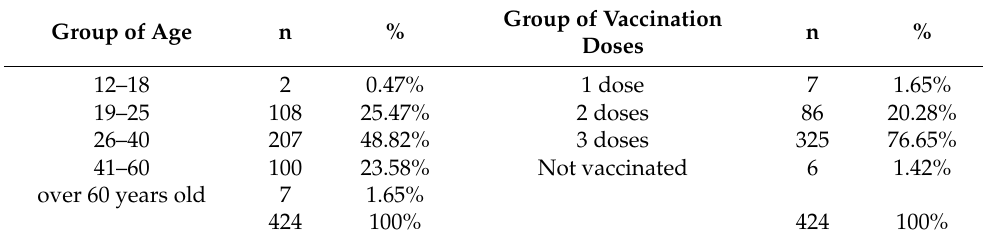
Table 1. Characteristics of questionnaire